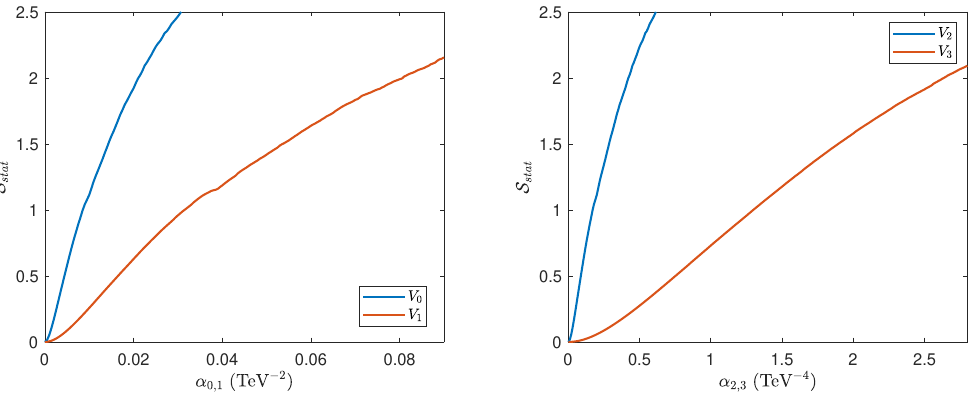
Figure 15 . The signal significances at L = 139 fb − 1 as functions of the coefficients of aQGCs.